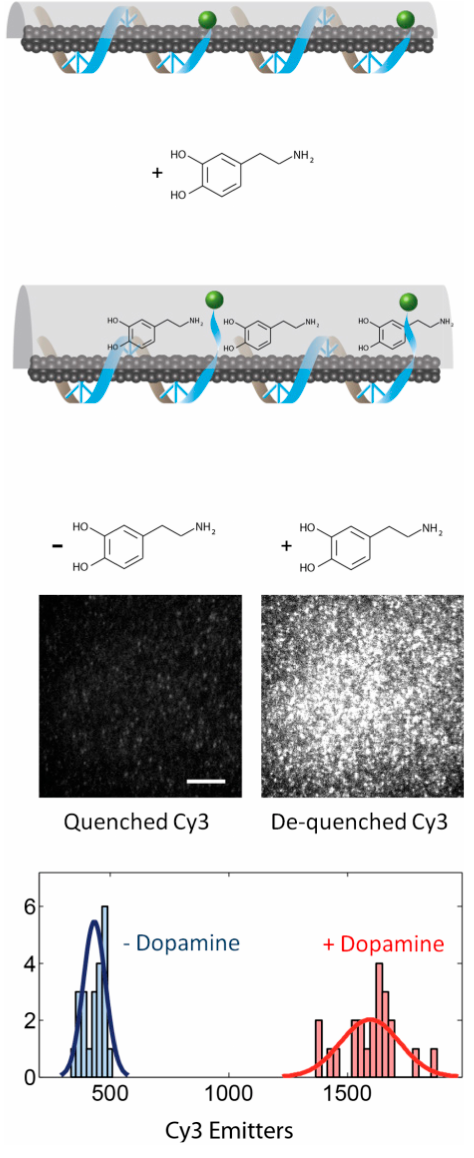
Figure 4. A schematic of the model suggests the displacement of the (GT)15 polymer enables dopamine to access the SWCNT corona to modulate the nIR intensity. Surface-immobilized (GT)15-Cy3-SWCNT show an increase in Cy3 fluorescence after dopamine addition, suggesting desorption of the Cy3 from the SWCNT surface